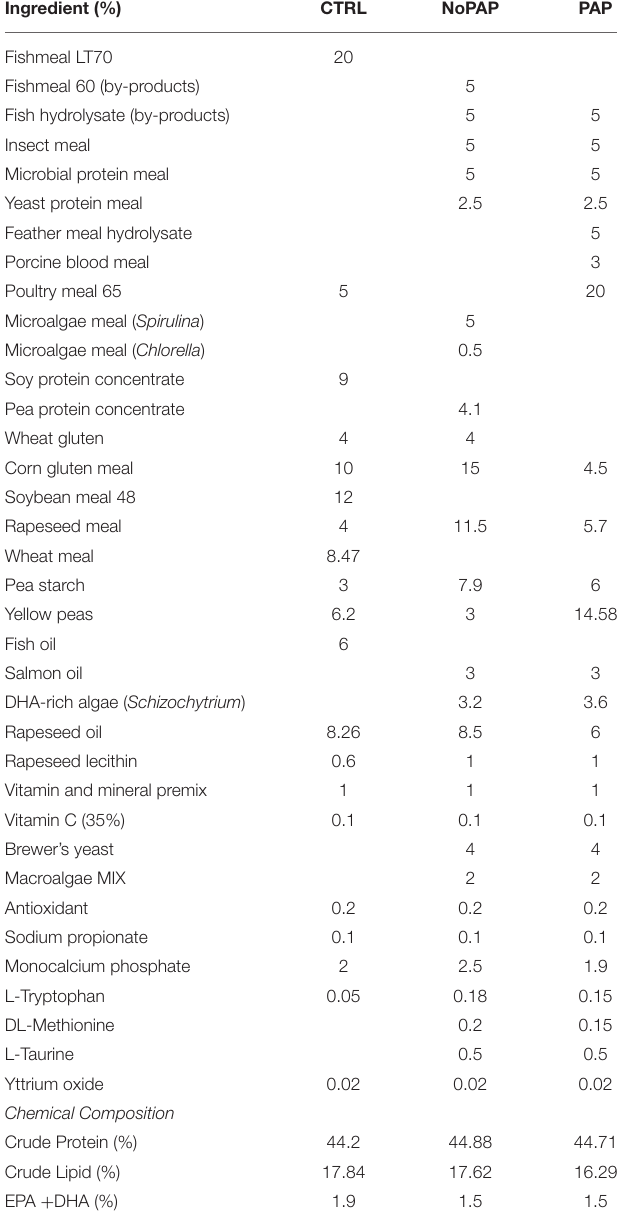
TABLE 1 | Ingredients and chemical composition of the experimental